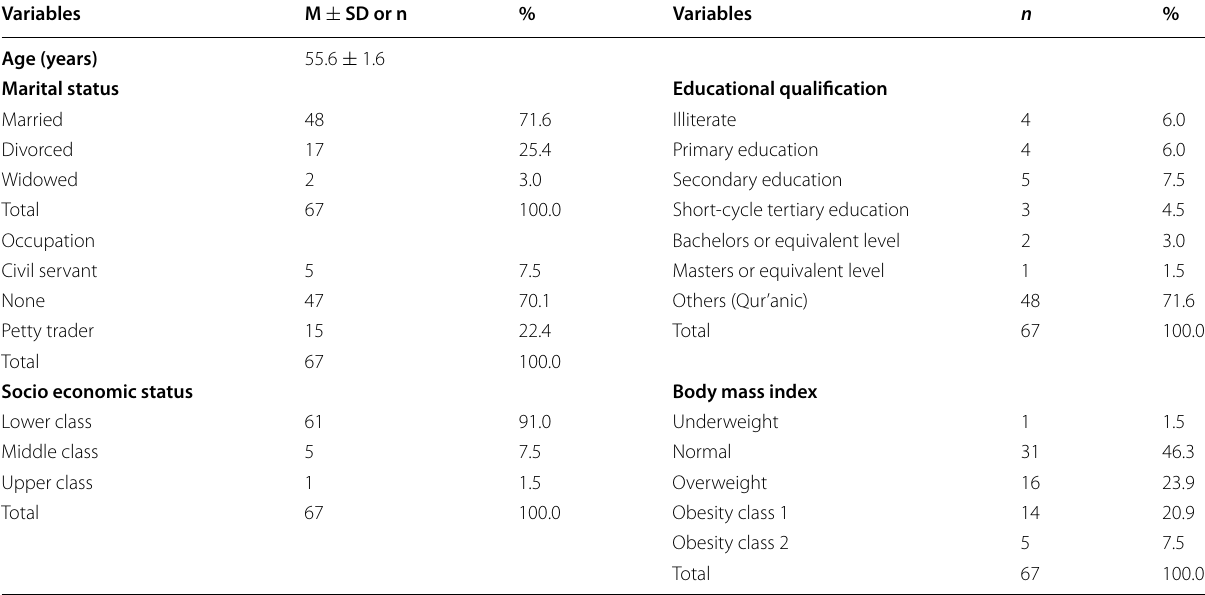
Table 1 Demographic and physical features of participants